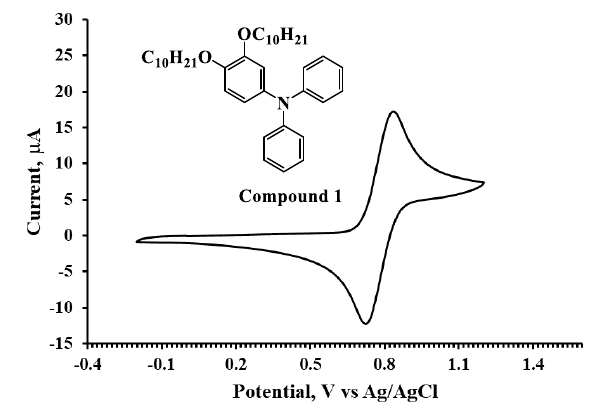
Figure 2. Cyclic voltammogram of Compound 1 in DCM solution (10 − 3 M).